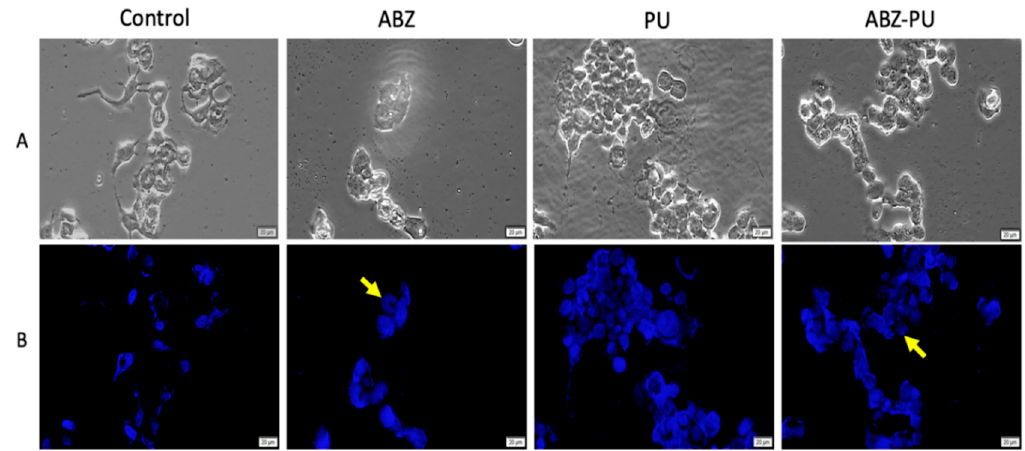
Figure 11. MCF7 cells stimulated with the highest concentration (100 µM) of test samples (ABZ, PU, ABZ-PU) for 24 h. ( A )—Bright field microscopy was used to observe the cell morphology; ( B )—Hoechst staining was employed to assess the specific apoptotic markers (chromatin condensation/DNA fragmentation). Scale bars represent 20 µm.